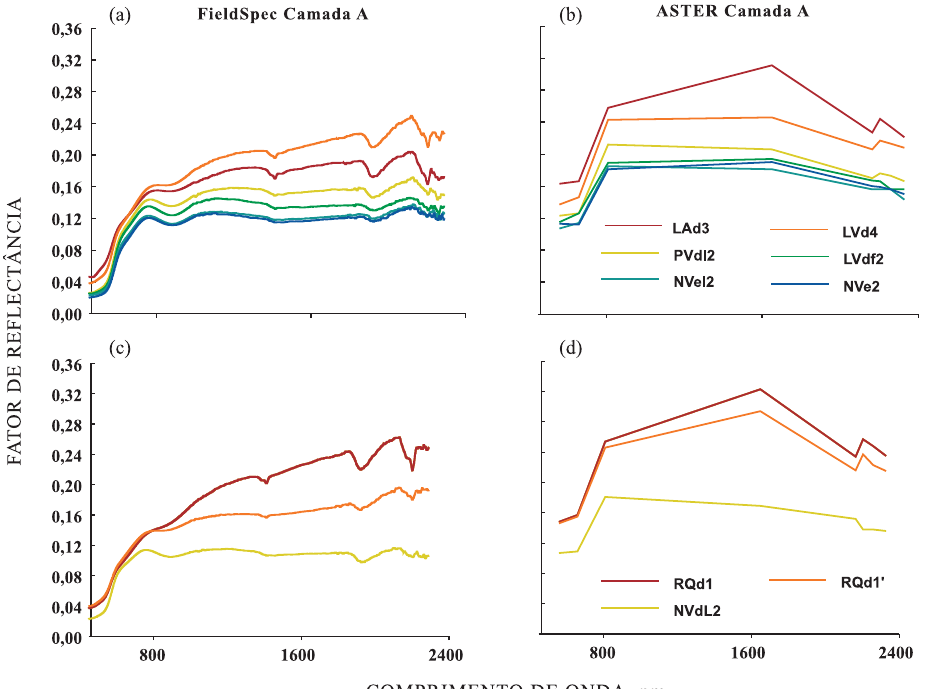
Figura 8. Avaliação da reflectância espectral de diferentes classes de solos por diferentes tipos de sensores (terrestre e